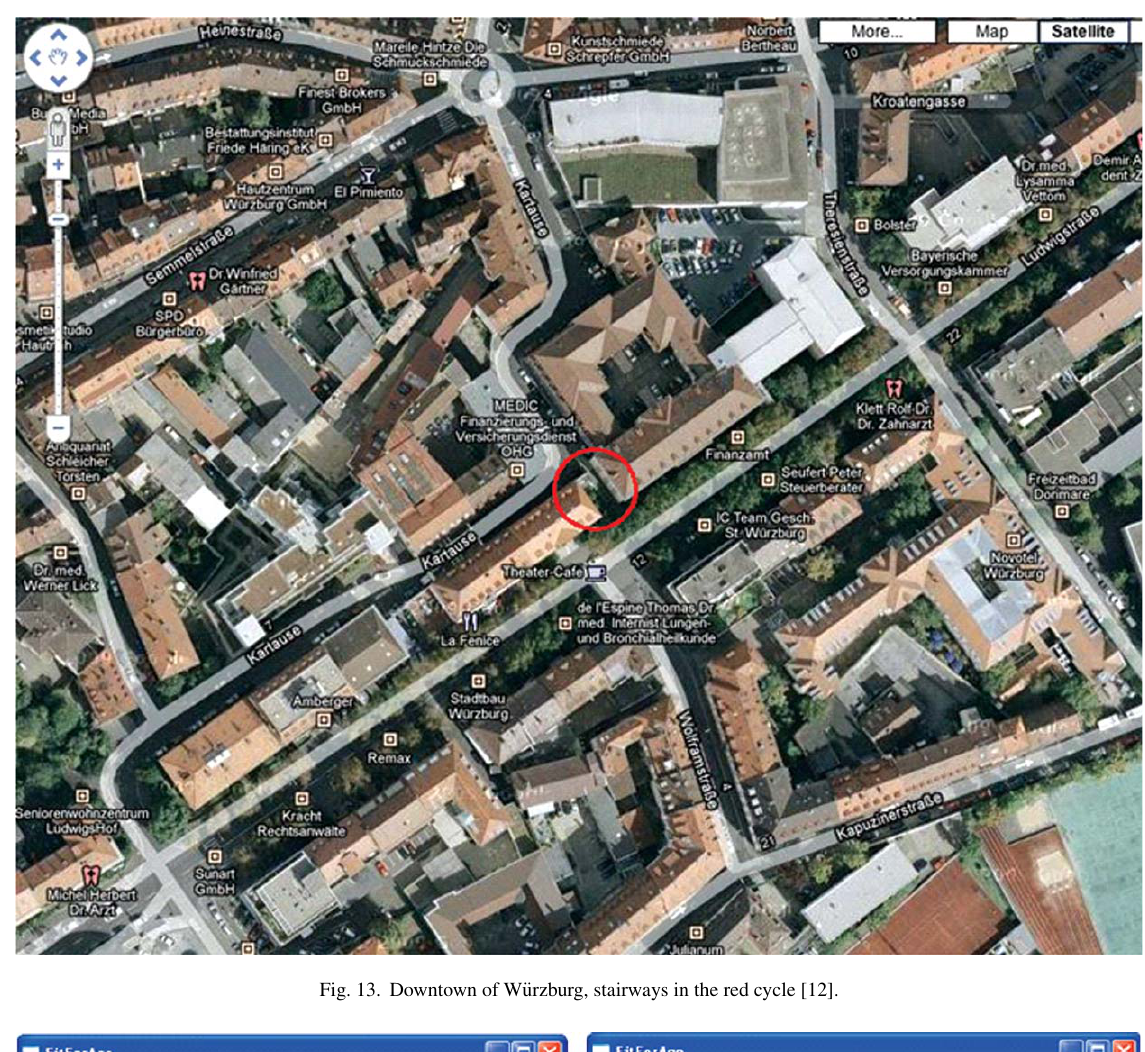
Fig. 13. Downtown of W¨urzburg, stairways in the red cycle [12].